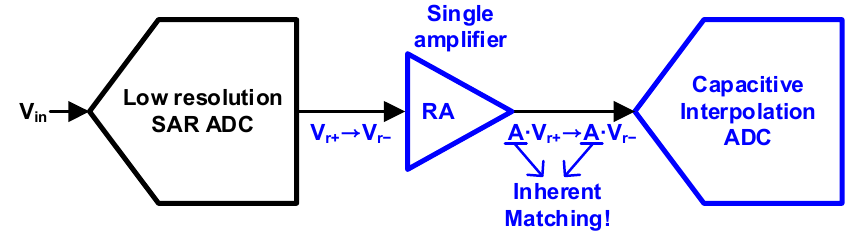
Figure 3. Interpolation schemes: ( a ) Resistor-based interpolation in [19,23]; ( b ) Capacitor-based interpolation in [20].